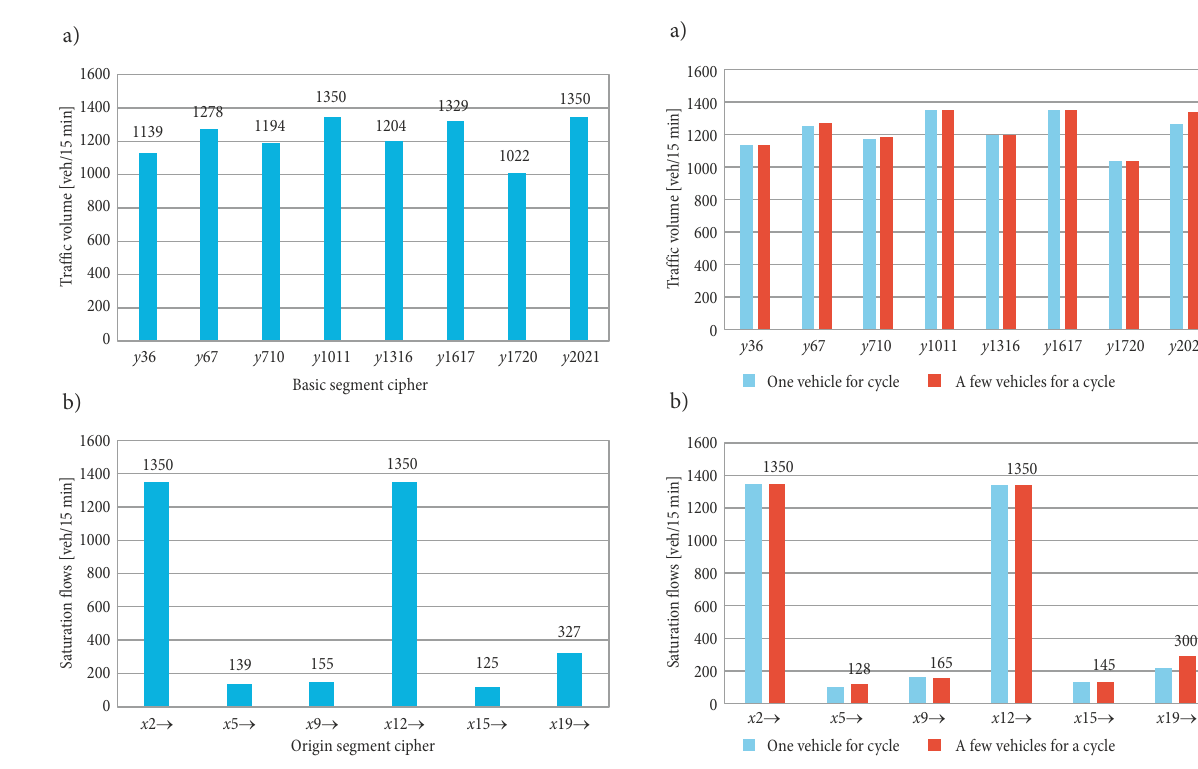
Fig. 10. Saturation flows considering the load on highway Fig. 9. Maximum saturation flows with the correspondence segments applying different strategies for managing ramp of the load on highway segments without restricting access flows: a – the load on highway segments; b – saturation to the network: a – the load on highway segments; b – saturation flows